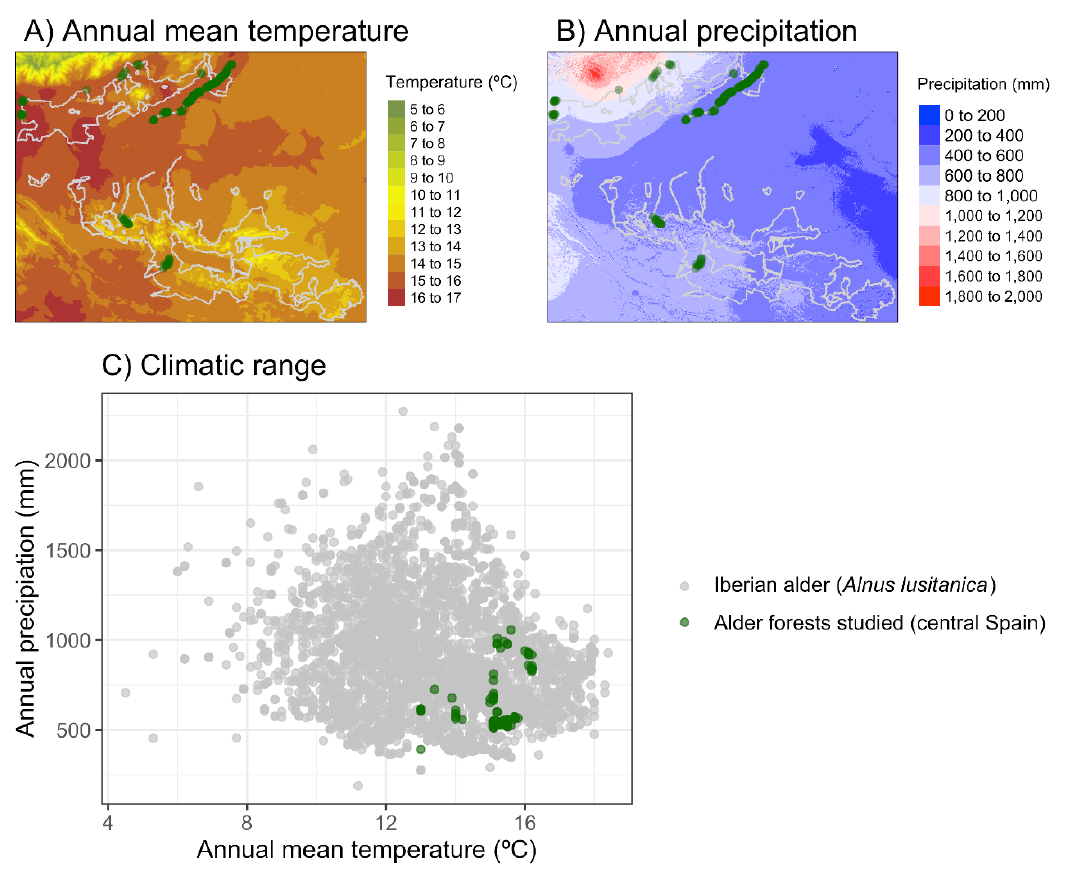
Figure 3. Annual mean temperature (ºC) and annual precipitation (mm) in the study area; A-B, climatic range of A. lusitanica (according to Vít et al ., 2017) in the Iberian Peninsula and occupied range in the study area (green points); C, source of the climatological data (Ninyerola et al .,